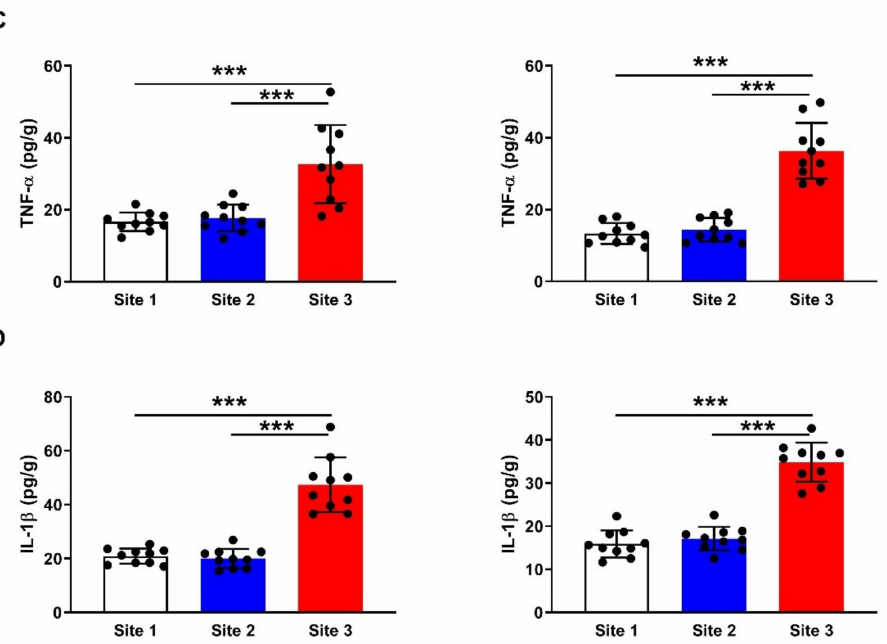
Figure 10. Liver and kidney TNF- α ( A ) and IL-1 β ( B ) mRNA abundance, and TNF- α ( C ) and IL-1 β ( D ) protein levels of camels at the studied sites. Data are mean ± SD ( n = 10). *** p < 0.001.